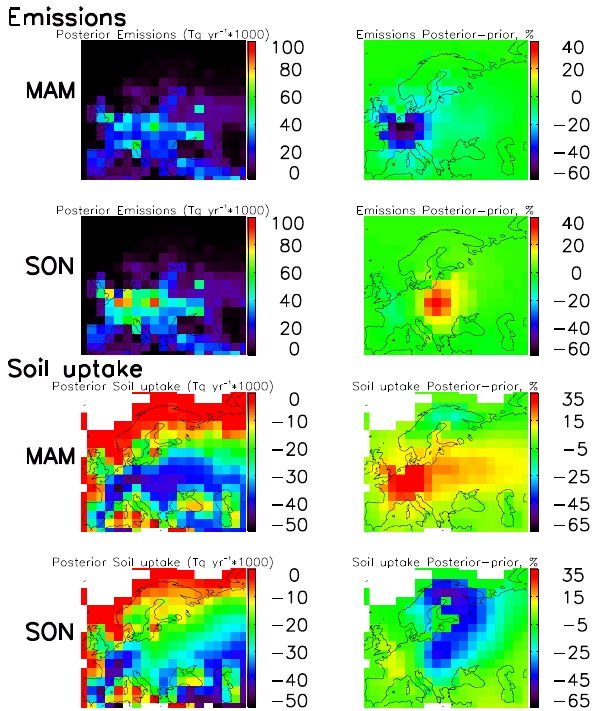
Fig. 8. S5 posterior flux map (on the left) and difference between S5 posterior and prior in % of the prior (on the right) fluxes for the surface emissions (above) and soil uptake (below) zoomed on Europe for March, April and May (MAM) and September, October and November (SON). Missing values are plotted in white.